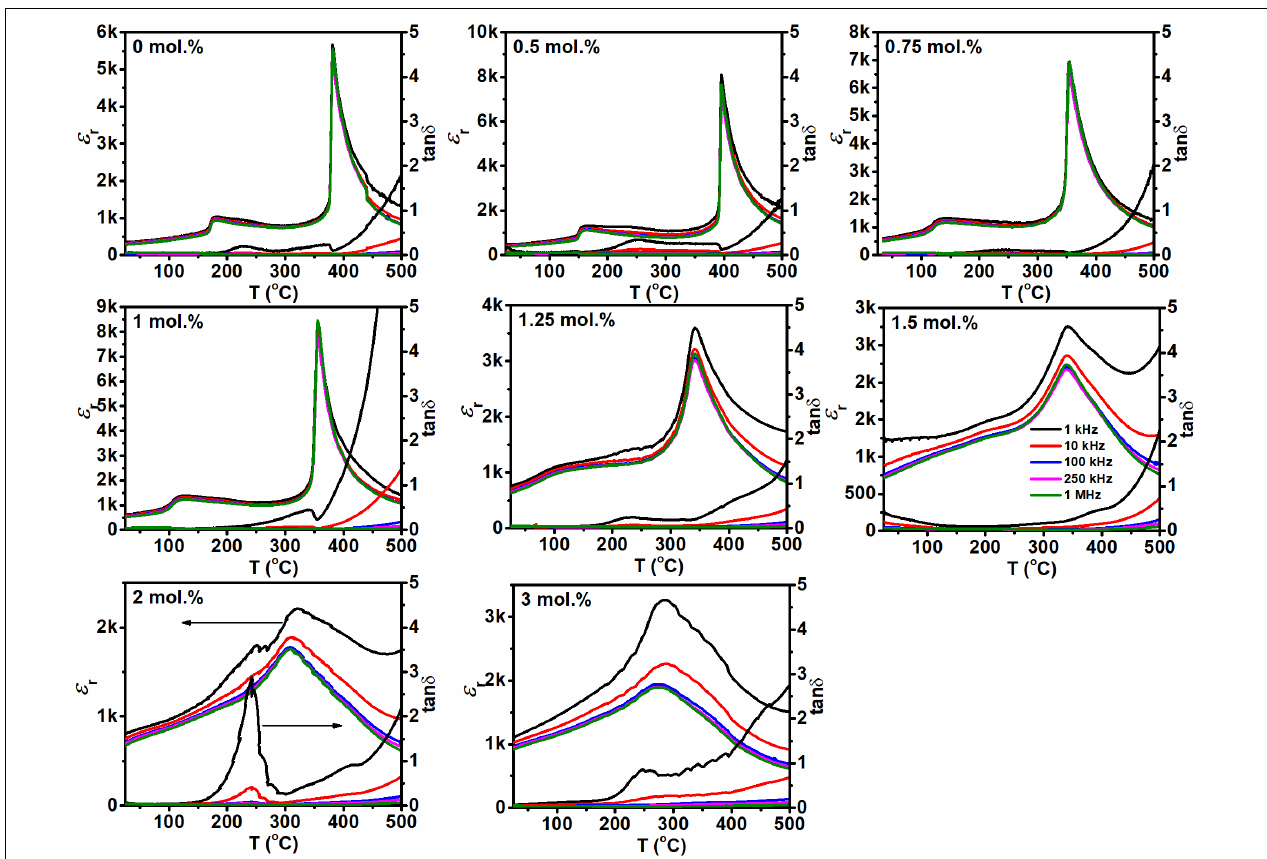
FIGURE 4 | Relative permittivity and tan δ as a function of temperature at constant frequencies of 1, 10, 100, 250 kHz, and 1 MHz for (1- x )K 0 . 4 Na 0 . 6 NbO 3 – x BiFeO 3 ( x = 1–3 mol.%) ceramics.